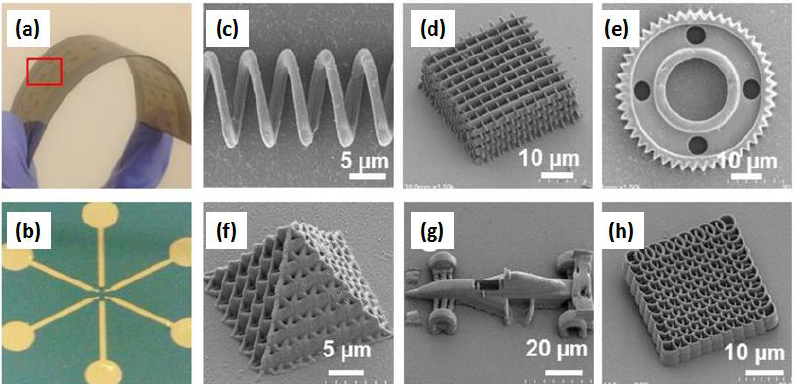
Figure 5. Functional micro/nanostructures fabrication based on MTA composite resins by TPP lithography. Bent polyethylene terephthalate (PET) substrate ( a ) and SiO 2 /Si substrate ( b ) used for TPP fabrication with Au electrode patterns; ( c – h ) Scanning electron microscopy (SEM) micrographs of various functional micro/nanostructures including a microcoil inductor ( c ); a woodpile ( d ); a microgear ( e ); a micro-pyramid ( f ); a microcar ( g ) and a spiral-like photonic crystal ( h ). The laser power and scanning speed used in the TPP fabrication were 15 mW and 0.5 mm/s, respectively. Copyright © 2016, with permission from SPIE [80].